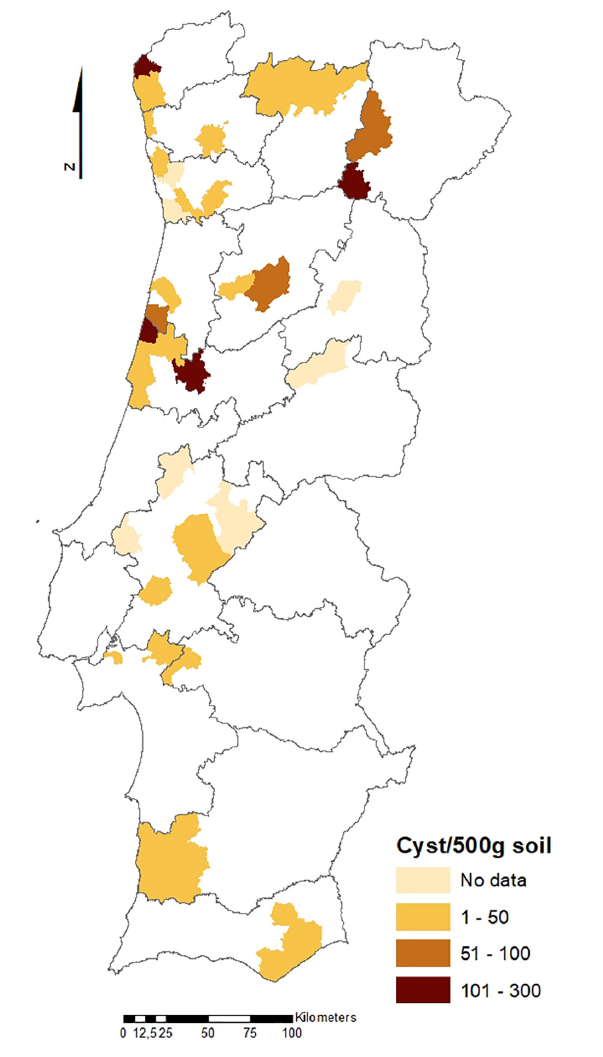
FIGURE 2 | Counties with positive detections of Globodera rostochiensis in Portugal between 2013 and 2019.